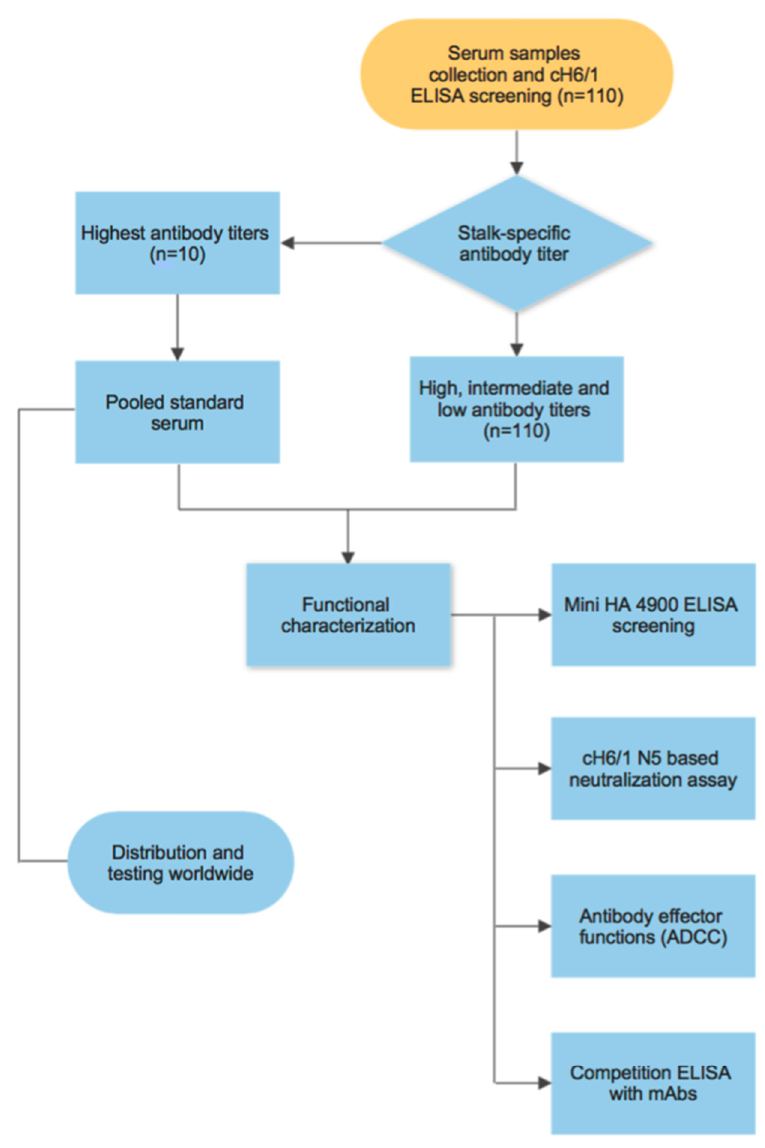
Figure 1. Workflow of the generation and characterization of a pooled serum as a candidate standard to measure influenza virus hemagglutinin stalk-reactive